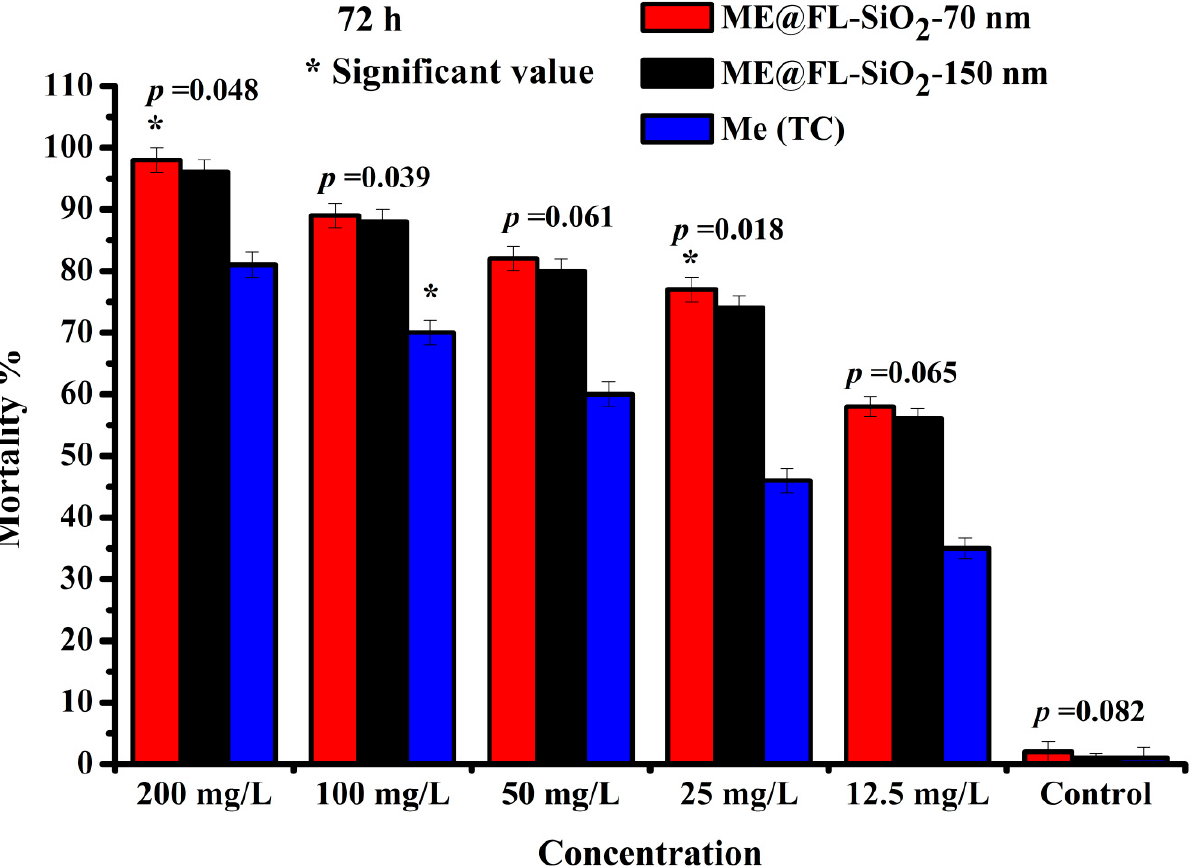
Figure 4. Mortality (%) of P. xylostella treated with Me (TC) and Me@FL-SiO 2 NPs-150 nm and -70 nm under different concentrations. * represents the significant values.